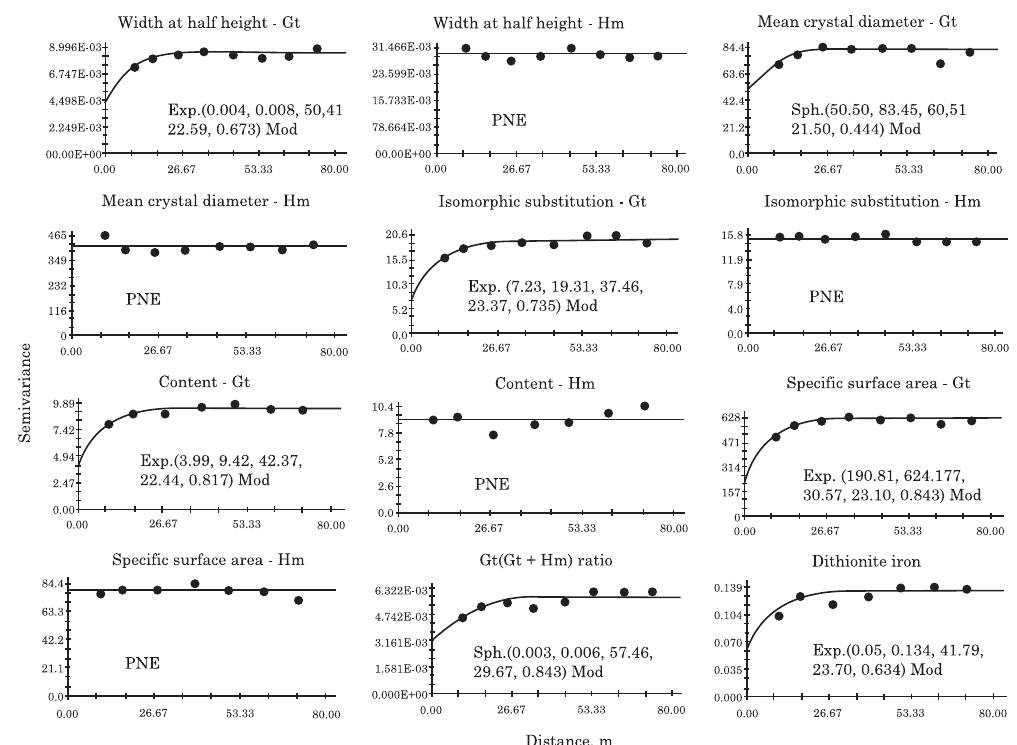
Figure 3. Semivariograms of the studied attributes in the concave area. Gt = goethite, Gt: goethite, Hm: hematite, PNE: Pure nugget effect, Sph.: Spherical, Exp.: Exponential, Mod: Moderate. Sequence of the semivariogram parameters: C o ; C 1 ; C o / (C o + C 1 ) (%); range; r 2 .